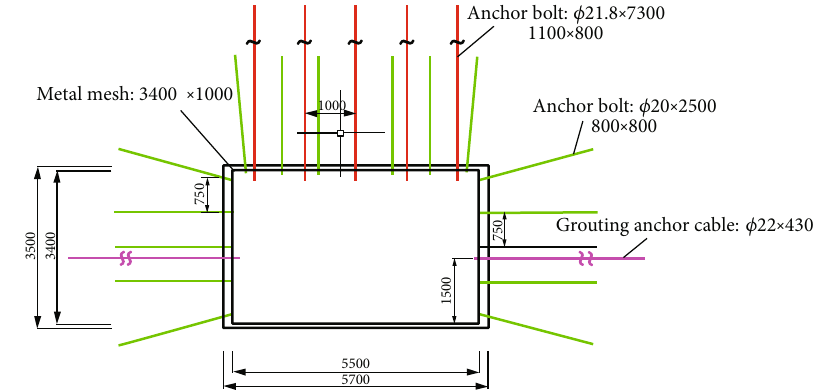
Figure 8: Diagram of roadway support section.